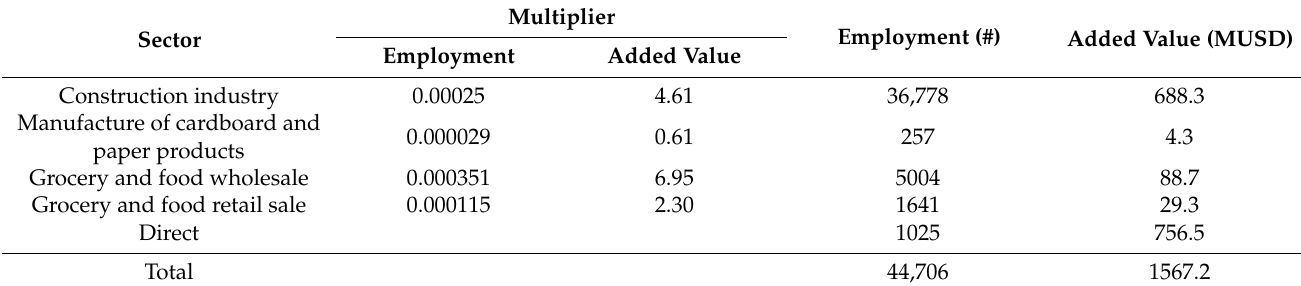
Table 9. Total socioeconomic benefits of the VCPVIM in the Baseline